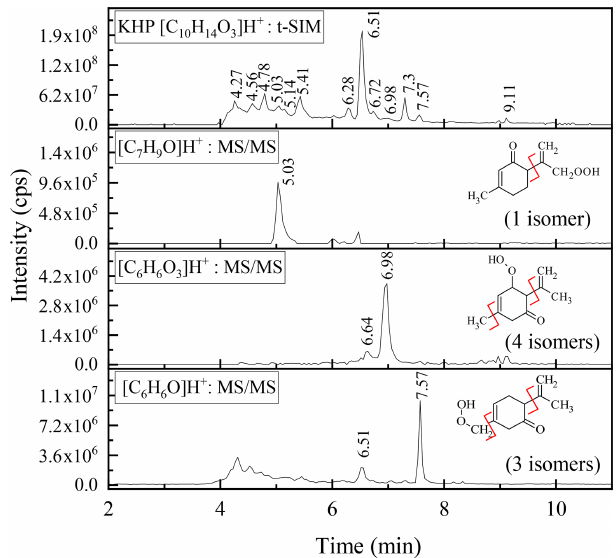
Figure 4. MS analyses of the KHPs isomers together with their fragmentation and number of possible isomers for each group (Fig.